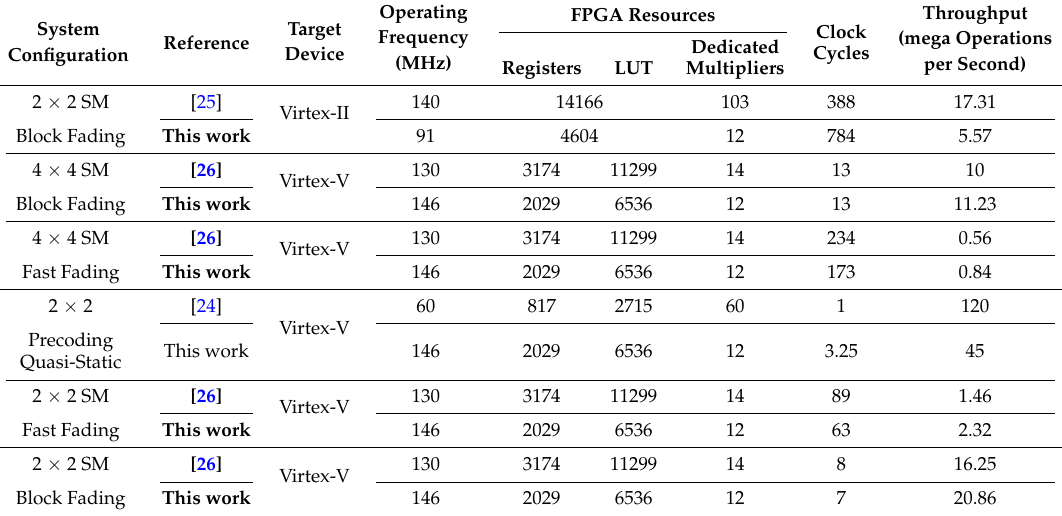
Table 5. Comparison summary of the proposed equalizer with relevant state-of-the-art